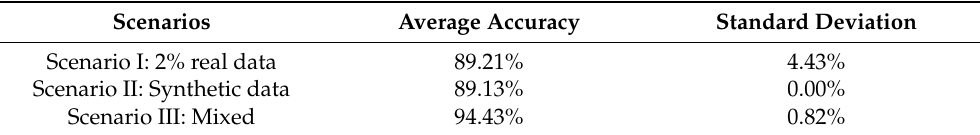
Figure 14. Accuracy of test set. Table 4. Comparison of